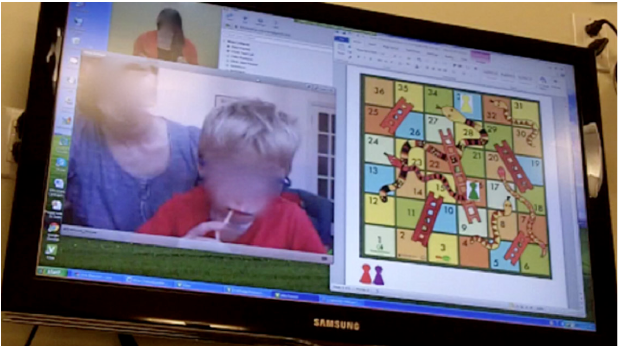
Figure 1. Telepractice therapy session. Image shows parent sitting next to child and facilitating session and board game shared via the VSee screen share